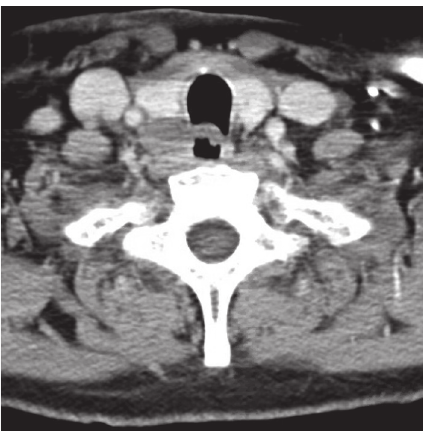
Figure 7: CT scan of the neck after 25 doses of pembrolizumab (axial image).